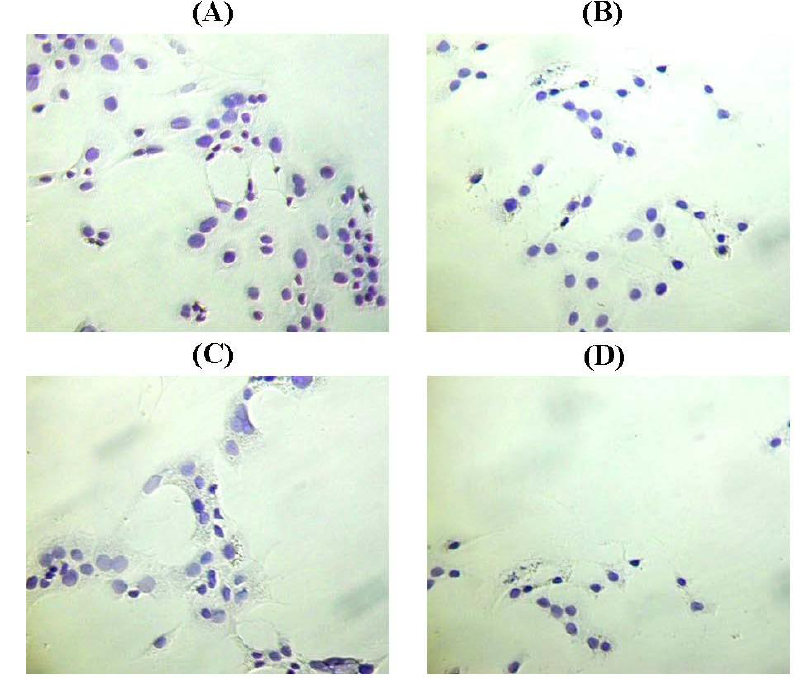
Figure 7. The morphologies of BT-474 cells preincubated with ( A ) Culture Condition 1; ( B ) Culture Condition 2; ( C ) Culture Condition 3; and ( D ) Culture Condition 4. One hundred cells were used as the input for incubation, and the incubation was carried out for 2 weeks. The cells were stained with Hemacolor Quick Staining. The pictures were taken with 200 × magnification, where 0.01 mm was equal to 10